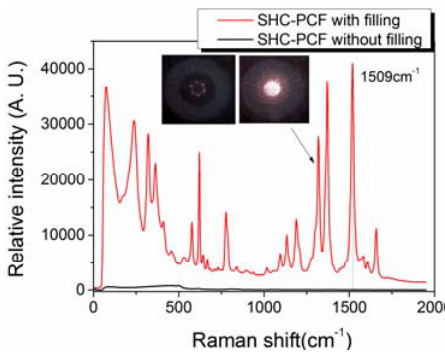
Figure 5. SERS signal of a 54 ‐ cm SHC ‐ PCF with and without AgPRs filled. Integration time is 300 ms, and excited power is around 9.5 mW.